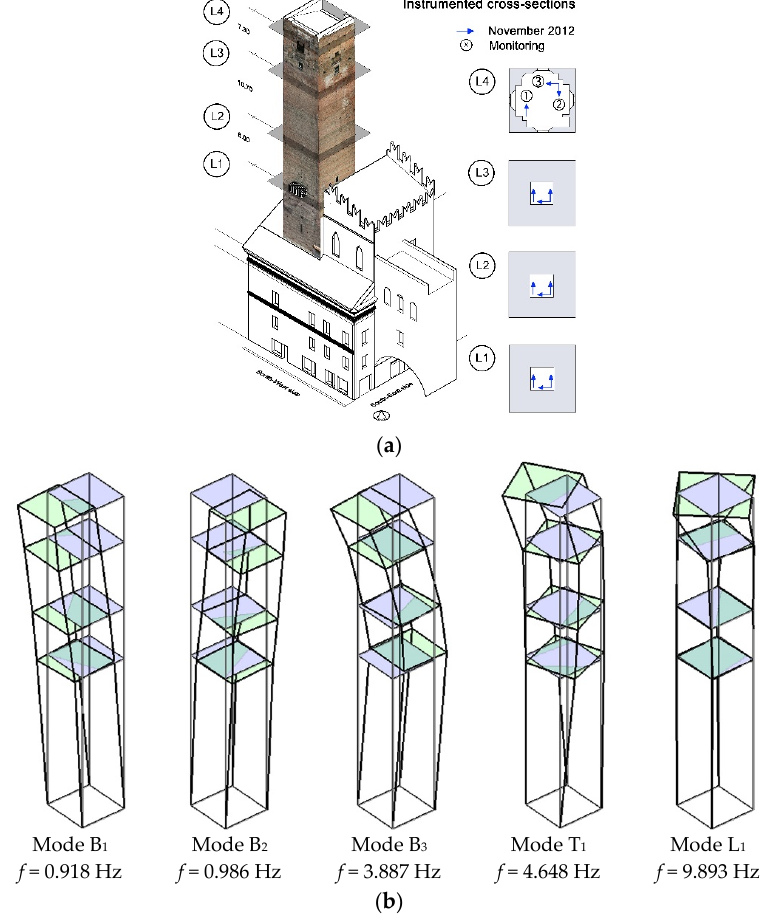
Figure 6. ( a ) Instrumented cross-sections and layout of the accelerometers during the preliminary tests (November 2012) and the continuous dynamic monitoring; and ( b ) vibration modes identified applying the data-driven stochastic subspace Identification algorithm (SSI-Data) to the data collected on 27/11/2012.